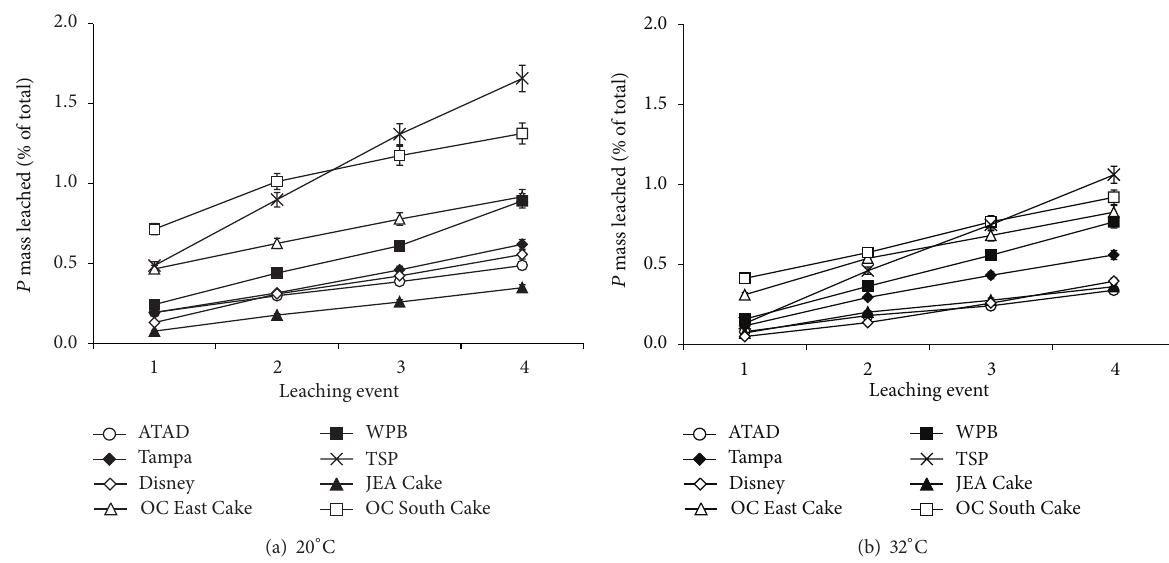
Figure 1: Cumulative P mass leached over the 90d incubation. Leaching events 1, 2, 3, and 4 correspond to 15, 30, 60, and 90 d of incubation. Initial P mass applied 112mgPkg −1 soil P (224kg Pha −1 ). Error bars represent one standard error. Data represent the average of three replicates. Error bars represent one standard error. Open symbols represent biological nutrient removal biosolids.